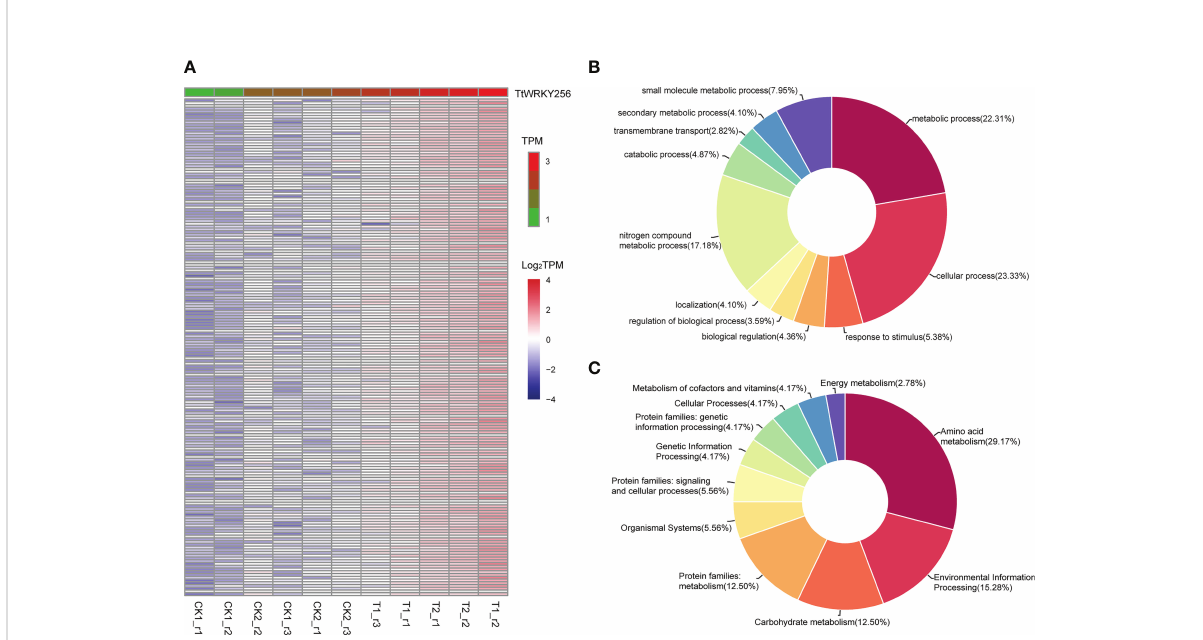
FIGURE 8 Expression correlation analysis of TtWRKY256. (A) One hundred eighty-one genes positively related (R>0.9) with TtWRKY256 expression; (B, C) the BP (B) and KEGG (C) analysis of 181 positively related to TtWRKY256 expression genes.